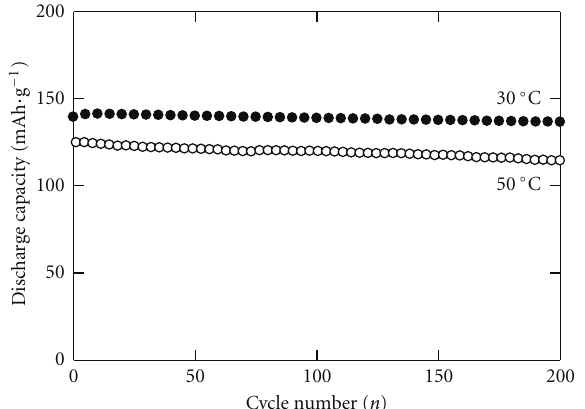
Figure 9: Relation between discharge capacity and cycle number at 30 ◦ C and 50 ◦